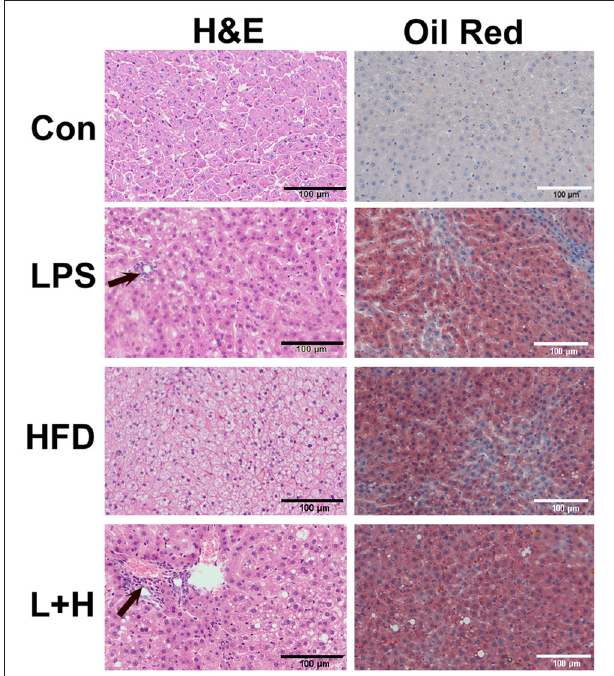
FIGURE 4 | Histopathologic observation of the liver in 8-week-old offspring rats. H&E staining was in left line and oil red staining was in right line. Arrow represented lymphomonocytic perivenular infiltration in liver. Con group, male offspring rats treated with prenatal saline and postnatal normal diet from 4 to 8 weeks old; LPS group, male offspring rats treated with prenatal LPS and postnatal normal diet from 4 to 8 weeks old; HFD group, male offspring rats treated with prenatal saline and postnatal high fat diet from 4 to 8 weeks old; L + P group, male offspring rats treated with prenatal LPS and postnatal high fat diet from 4 to 8 weeks old.